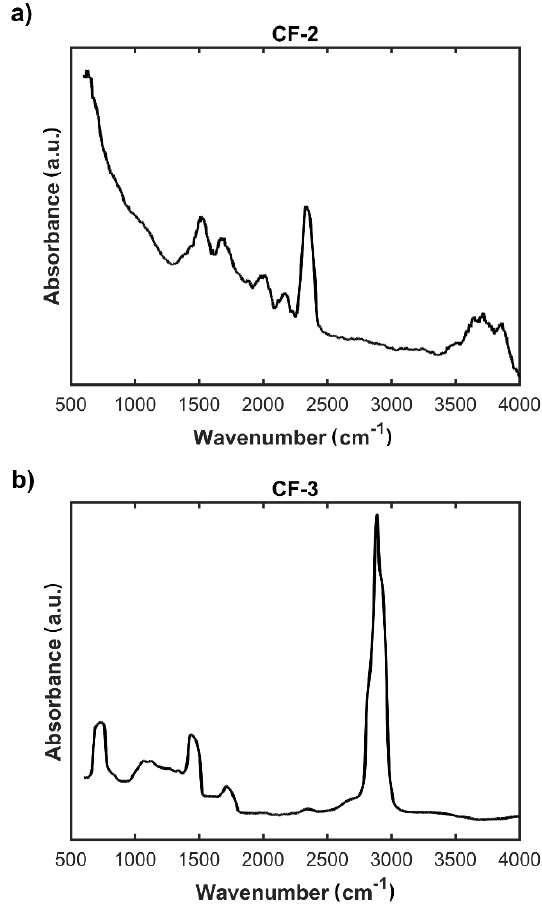
Figure 7. FTIR spectra of: ( a ) modified carbon nonwoven fabric containing C 6 H 4 -CONH-CH 2 CH 2 - NH 2 on the surface ( CF-2 ); ( b ) modified carbon nonwoven fabric containing C 6 H 4 -CONH-CH 2 CH 2 - NH-DGR-Ac on the surface ( CF-3 ).